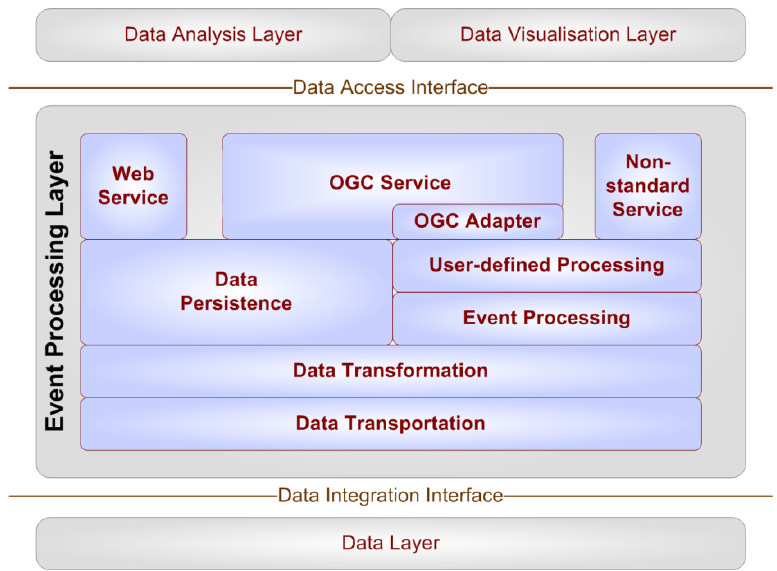
Figure 10. Internal Service Stack of the CEP